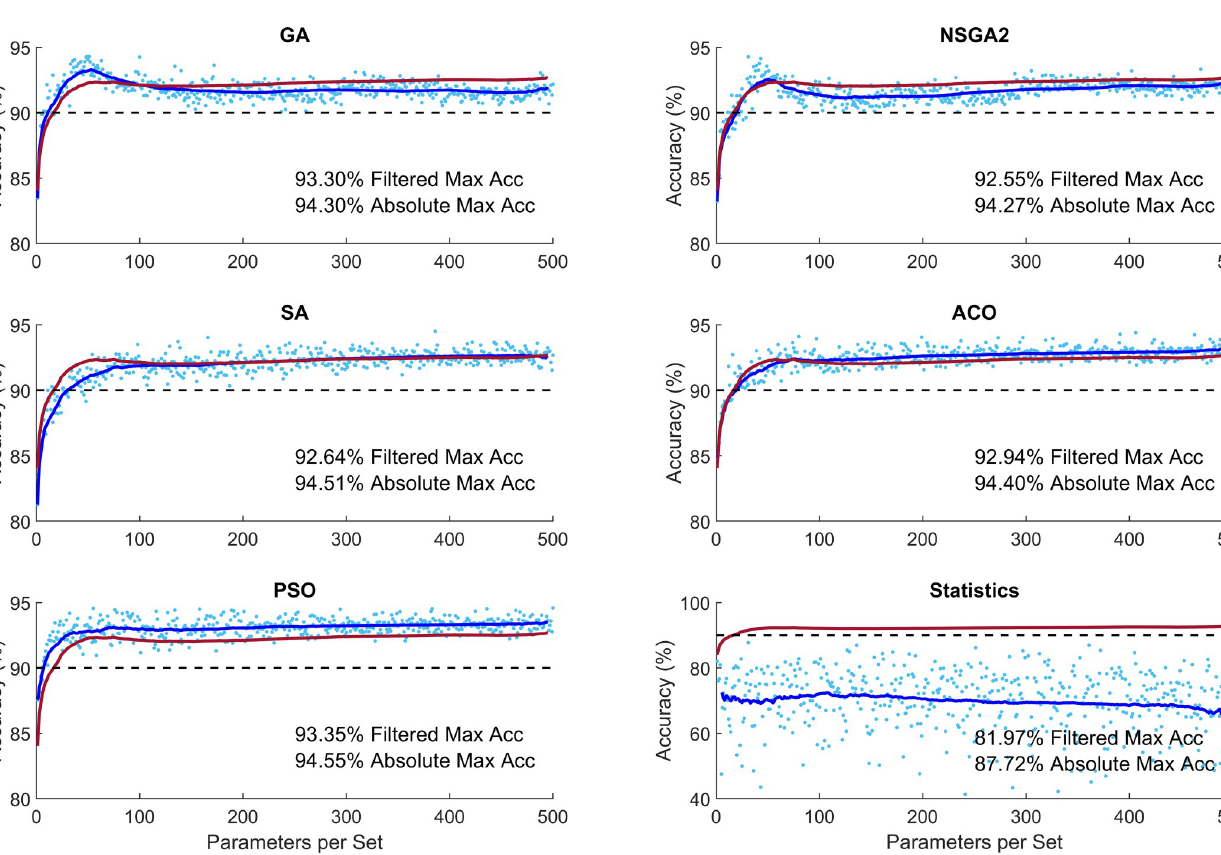
PLOS ONE | https://doi.org/10.1371/journal.pone.0267608 June 21,